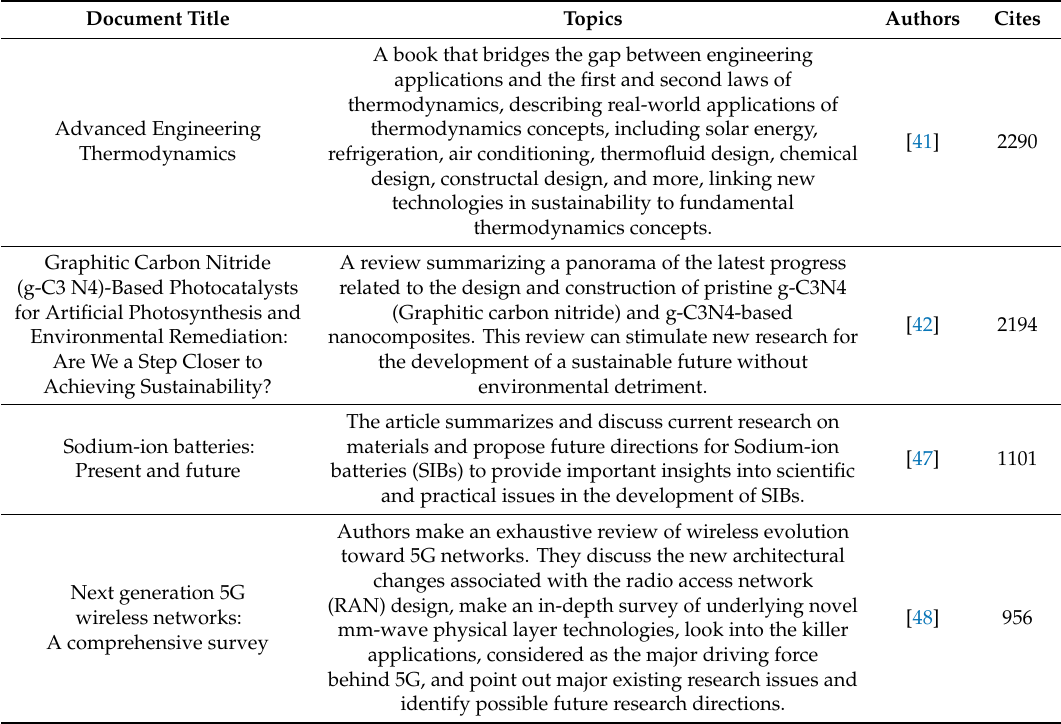
Table 7. Most cited documents in 2016–2020.